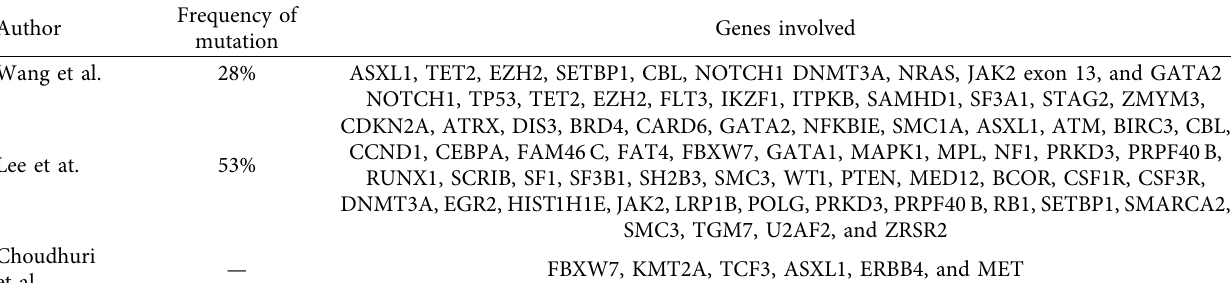
Table 2: Mutations identified in the